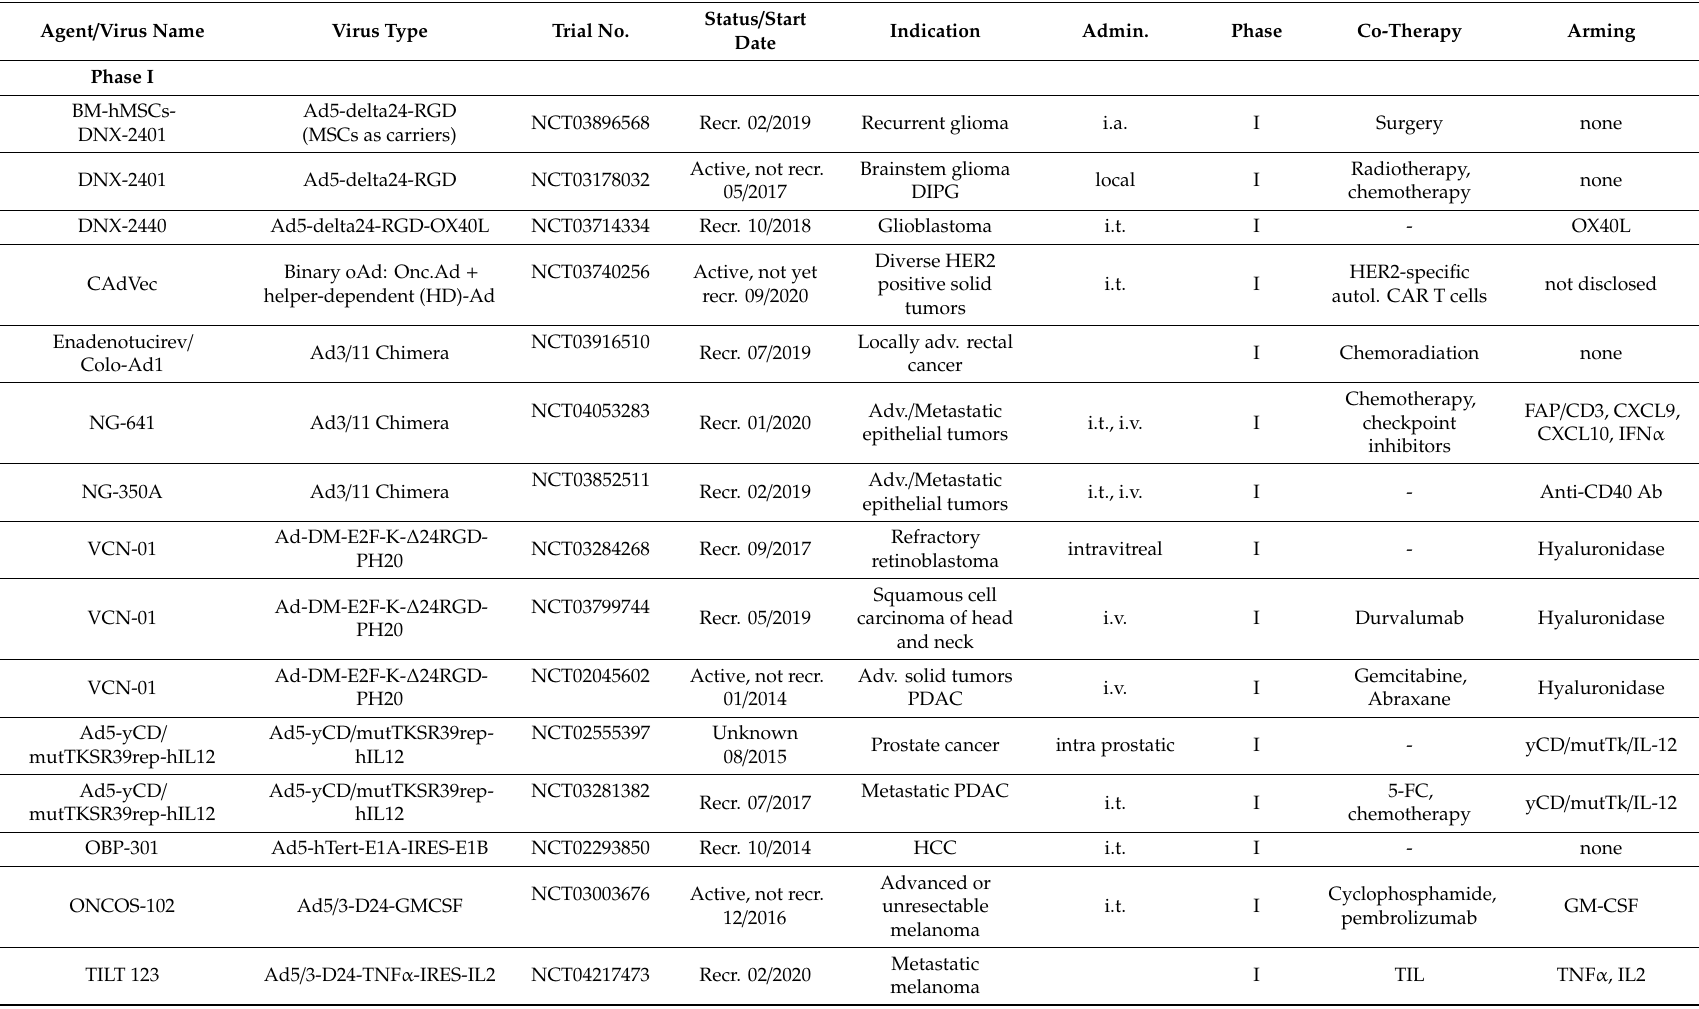
Table 1. Currently running clinical trials on oncolytic adenoviruses according to https: //